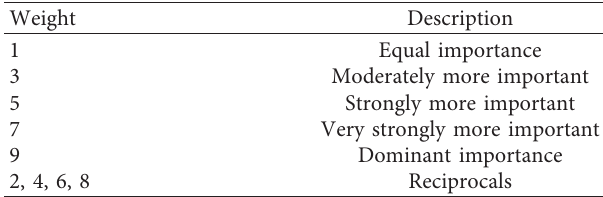
Table 3: Saaty’s scale for AHP pairwise comparisons [25,